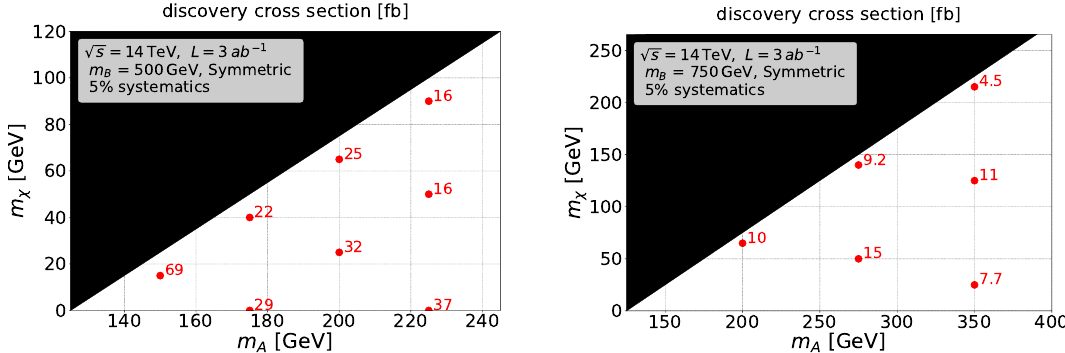
Figure 10 . Cross sections (in fb) required for a discovery at the HL-LHC in the m A (cid:0) m (cid:31) plane for the symmetric model, with m B = 500 GeV (left panel) and m B = 750 GeV (right panel).